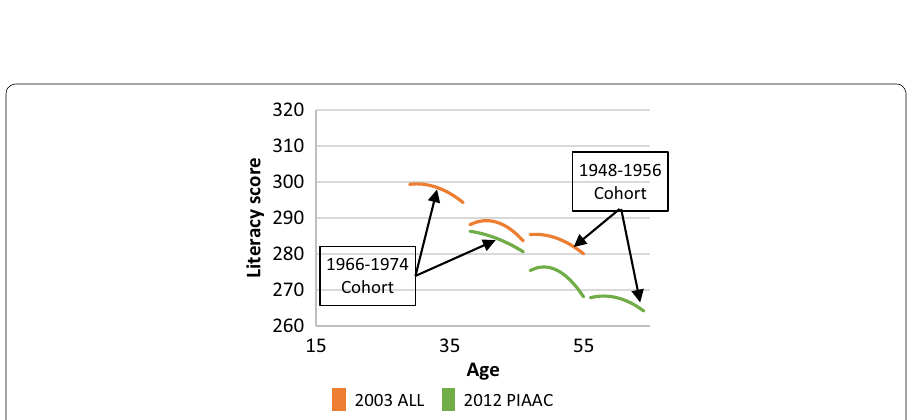
Fig. 3 Age-literacy relationship for three native-born cohorts, Canada, 2003 ALL and 2012 PIAAC The predicted values of the literacy score are generated by regression models stratified by cohort and survey year. These models also include the following control variables: sex, province of residence, type of region (urban/ rural), level of education, knowledge and use of official languages, mother’s level of education, practice of literacy activities at home, and use of writing skills at work (and labour market participation